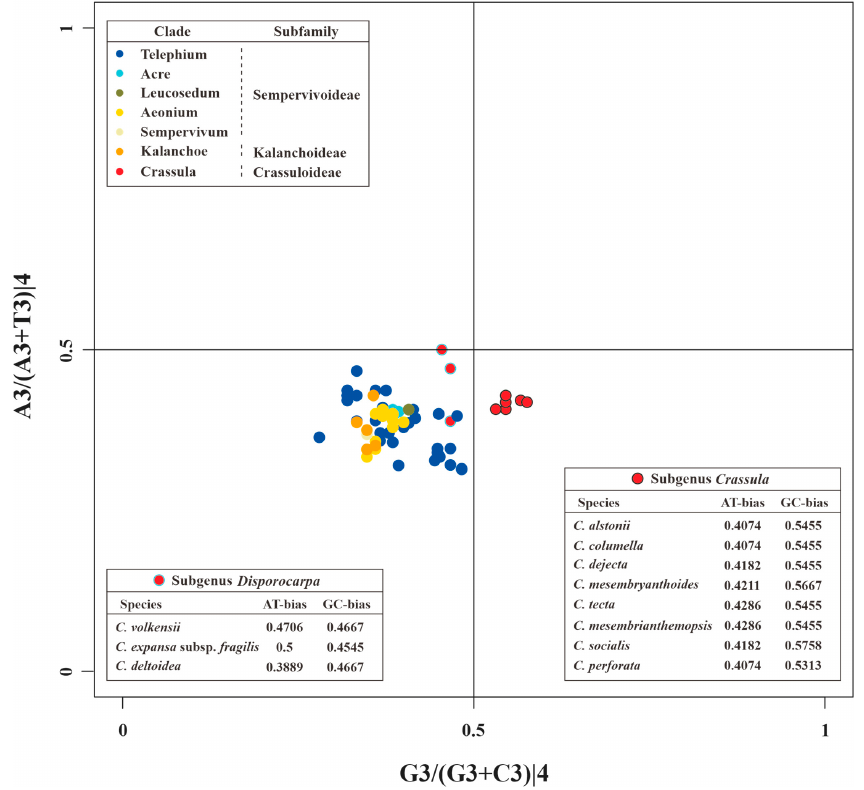
Figure 7. The PR2 plot of matK of Crassulaceae. Different colors represent different clades. Within the clade Crassula (or genus Crassula ), red circles with black edges and cyan edges represent species of subgenus Crassula and Disporocarpa , respectively. Table 3. The specific codon aversion motifs of Crassula within